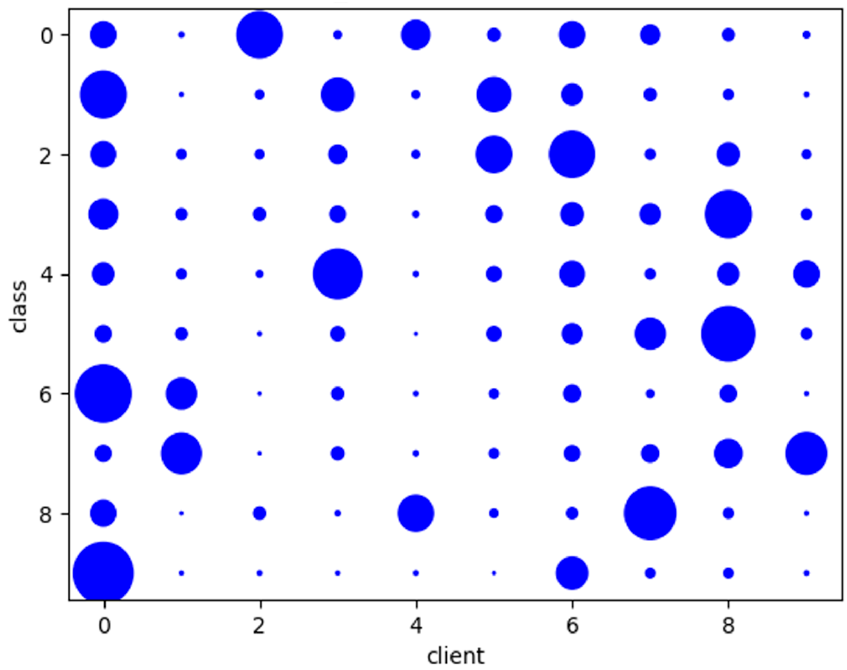
Figure 9. The statistical distribution of the top-1 feature space density’s entropy.